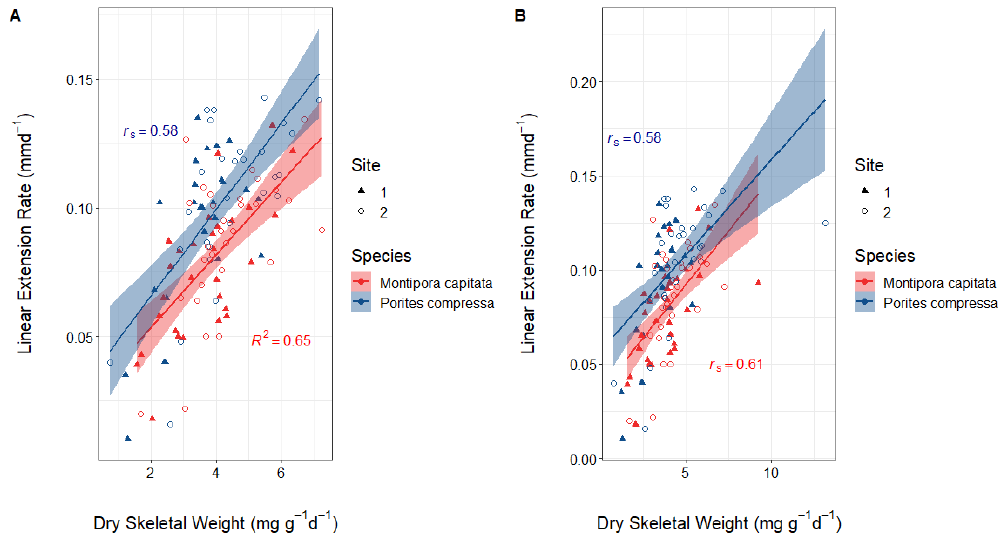
Figure 3. Correlations between dry skeletal weight and linear extension rates for both P. compressa and M. capitata ( A ) with the outliers removed and ( B ) with the outliers left in. ( A ) The data for M.